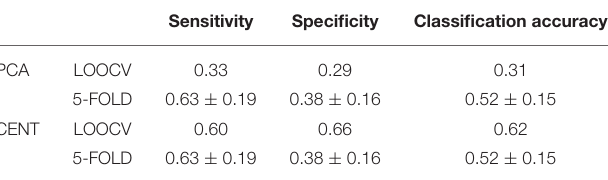
TABLE 7 | Same as in table 6 but for ML-FCG iPLV .